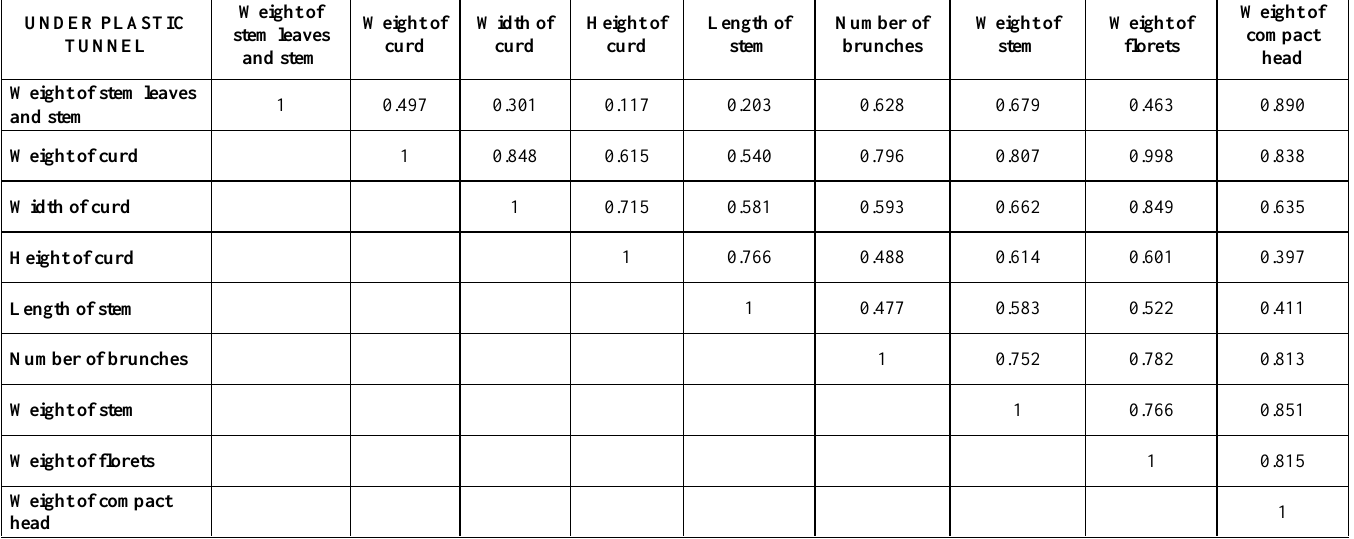
Table 1. Correlation matrix for different quality parameters in the mean of